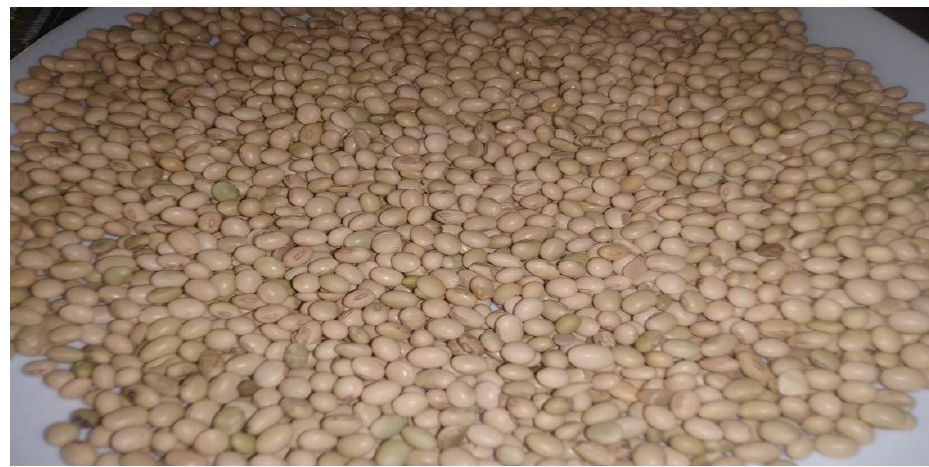
Figure 4. Soybean seed.